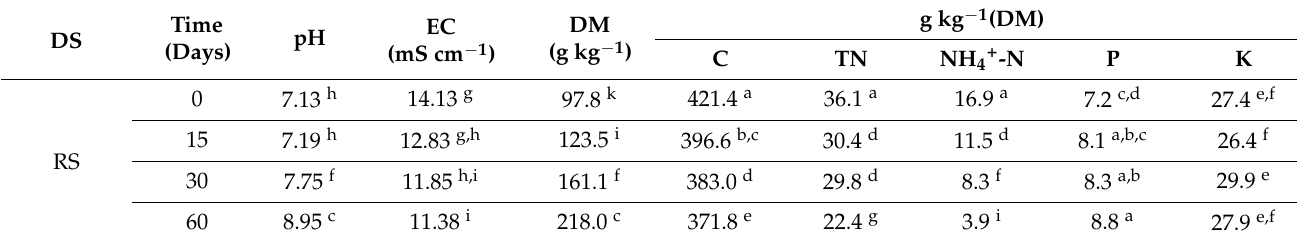
Table 5. Physicochemical analysis (pH, EC, DM, OM, TN, NH 4+ -N, P and K) of raw and treated dairy slurry (DS2), at the beginning of the storage test (t = 0 d) and after 15, 30 and 60 days (t = 15, t = 30 and t = 60 d) (Mean, n = 3). Slurry samples were acidified to pH 5.0 (AC), alkalinized to pH 9.5 (AL), and a combined treatment alkalinization/neutralization (NE) was also